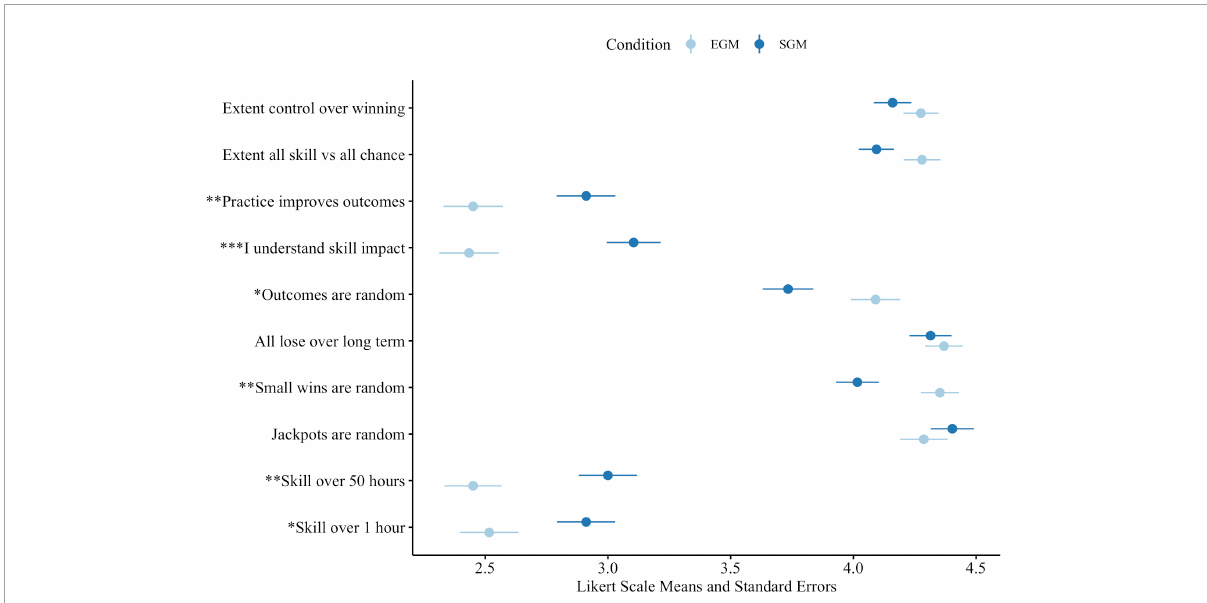
FIGURE1 Game understanding item mean responses based on EGM/SGM assignment condition. * p < 0.05, ** p < 0.01, *** p <